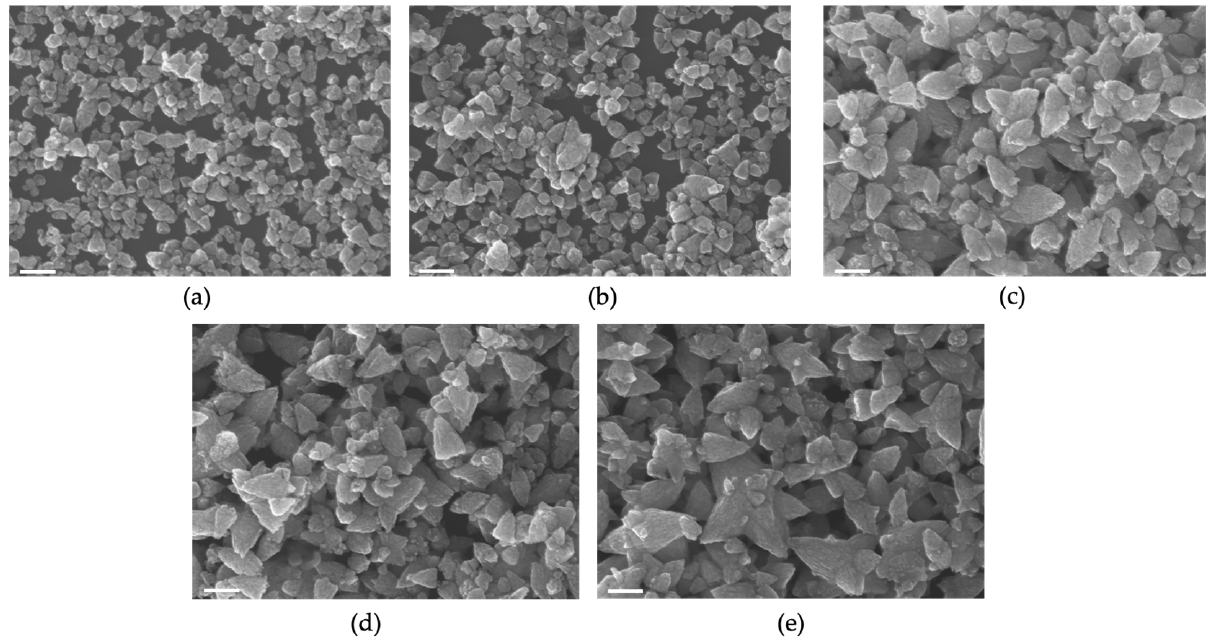
Figure 1. FE-SEM images (scale bar: 200 nm) of ( a ) pure ZnO nanoparticles; ( b ) 2% Mg-doped nanopar- Figure 1. FE ‐ SEM images (scale bar: 200 nm) of ( a ) pure ZnO nanoparticles; ( b ) 2% Mg ‐ doped na ‐ ticles; ( c ) 5% Mg-doped nanoparticles; ( d ) 7% Mg-doped nanoparticles; ( e ) 10% Mg-doped noparticles; ( c ) 5% Mg ‐ doped nanoparticles; ( d ) 7% Mg ‐ doped nanoparticles; ( e ) 10% Mg ‐ doped nanoparticles.